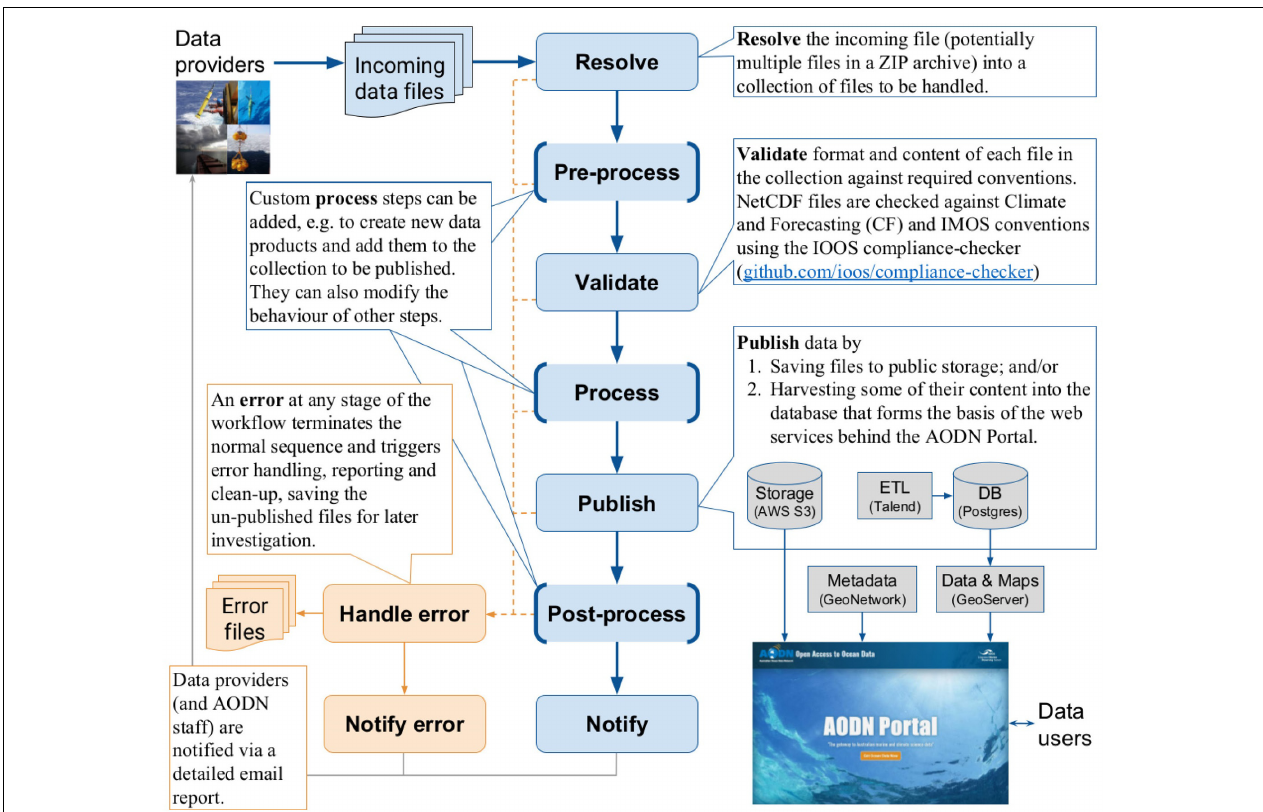
FIGURE 6 | Generic, customizable workflow of the AODN data ingestion system (Hidas et al.,